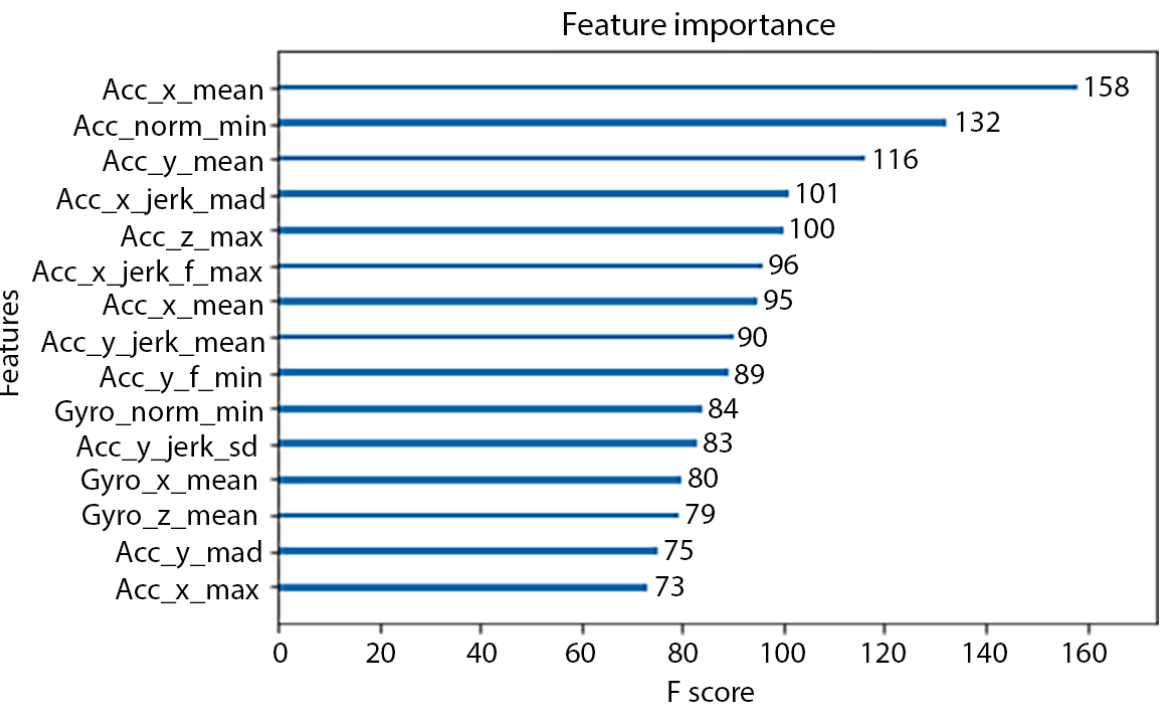
Figure 16. Importance of the top 15 features from Xgboost using greedy Gaussian segmentation from the BREATHE dataset. Abbreviations in the feature names are SD, minimum (min), maximum (max), mean absolute deviation (mad), Euclidean magnitude (norm), and derivative (jerk). The operators in the names should be read in the order of from the right to the left. For example, acc_x_jerk_max means the maximum value of the derivative values on the x-axis of the accelerometer